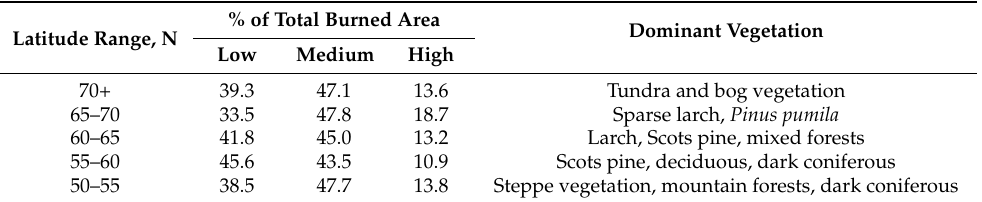
Table 3. Percent of low-, medium- and high-intensity fire areas on a latitudinal gradient and associ- ated dominant vegetation types.